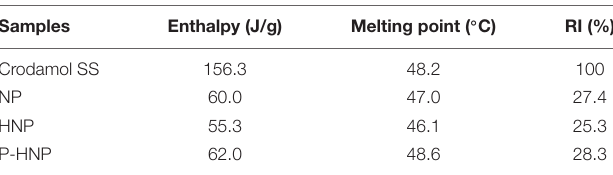
TABLE 2 | Enthalpy, melting point, and recrystallization index (RI) of solid lipid (Crodamol SS), NP , HNP , and P-HNP . Samples Enthalpy (J/g)